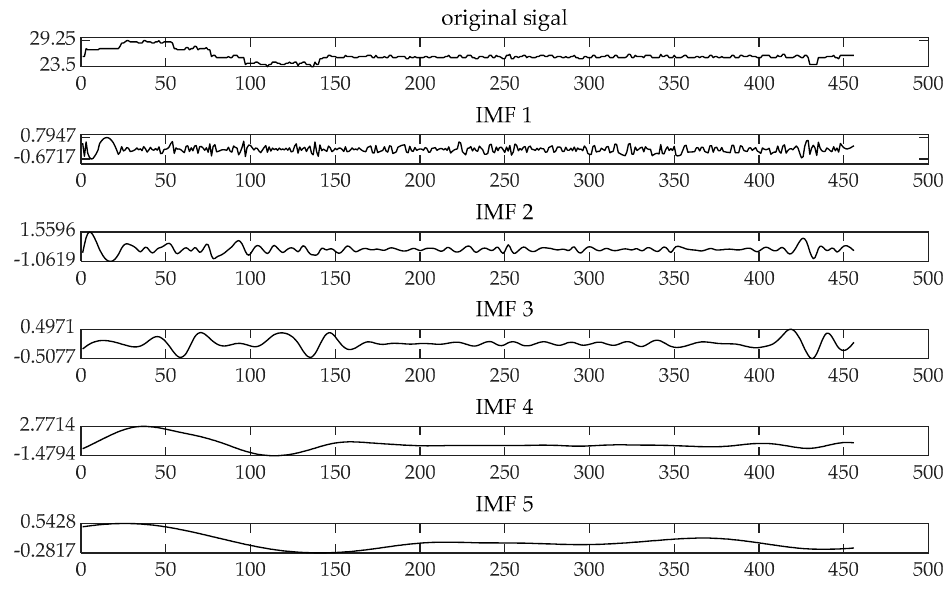
Figure 10. Results of the HST output speed signal’s EMD decomposition.